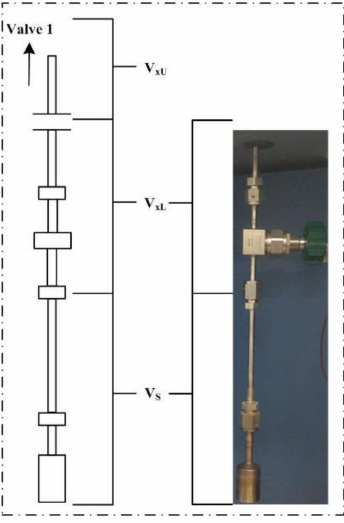
Figure 3. Three sections of the sample